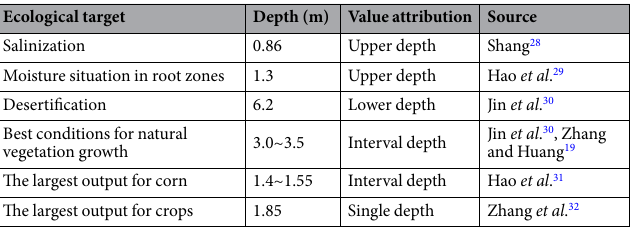
Ecological target Depth (m) Value attribution Source Salinization 0.86 Upper depth Shang 28 6.2 3.0~3.5